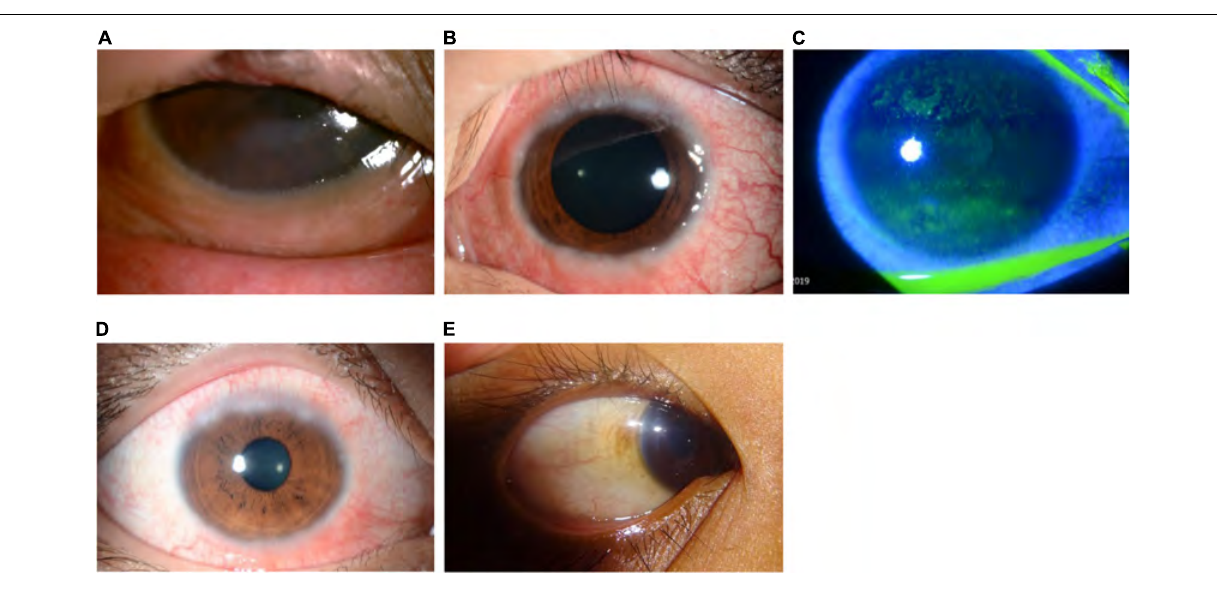
FIGURE 3 | Clinical subtypes of VKC: Limbal form . The limbal form typically involves Horner–Trantas dots (see Figure 5 ), indicating lymphocytic and eosinophilic infiltration of the limbal conjunctiva. The mixed form is characterized by the presence of both tarsal and limbal subtypes in only one eye. (A) Image courtesy of Wei-Li Chen; (B–D) images courtesy of Jodhbir S. Mehta; (E) image courtesy of Florence